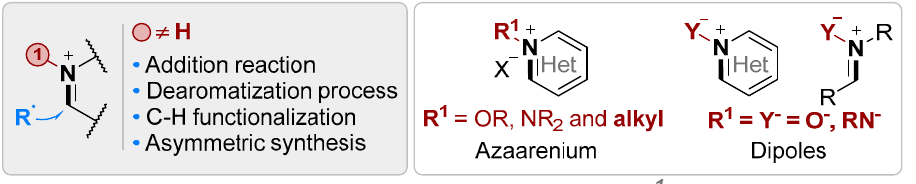
Figure 2. Scope of this review.